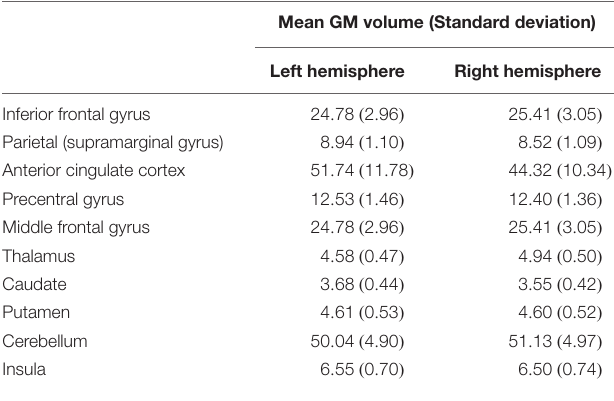
TABLE 1 | Mean and standard deviation of grey matter (GM) volumes (cm 3 ) of our region of interests (ROIs).